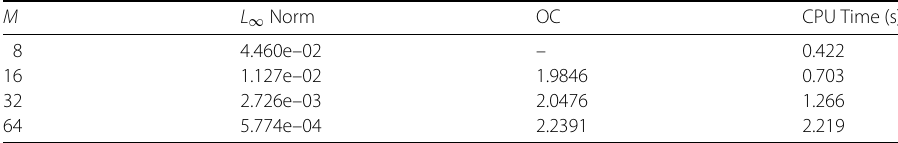
Table 4 Order of convergence for various values of M when τ = 0.01, γ = 0.9 for Example 2